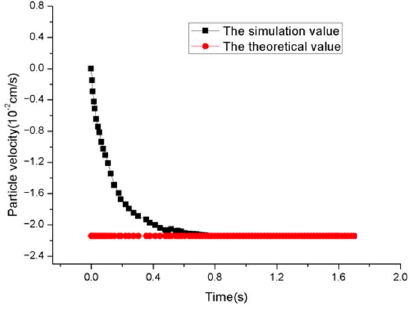
Figure 2. Settling velocity for the spherical particle.